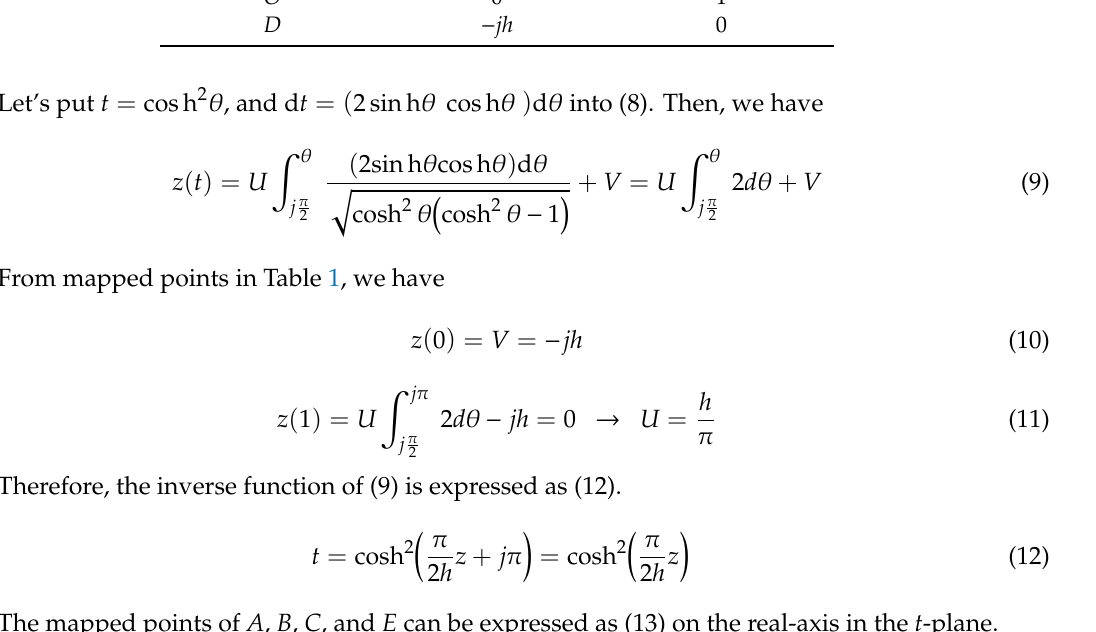
Figure 6. Conformal mapping of Region 2: ( a ) z -plane, ( b ) t -plane. Table 1. Mapped points between the z -plane and t -plane in Region 2. Symbol z -Plane t -Plane